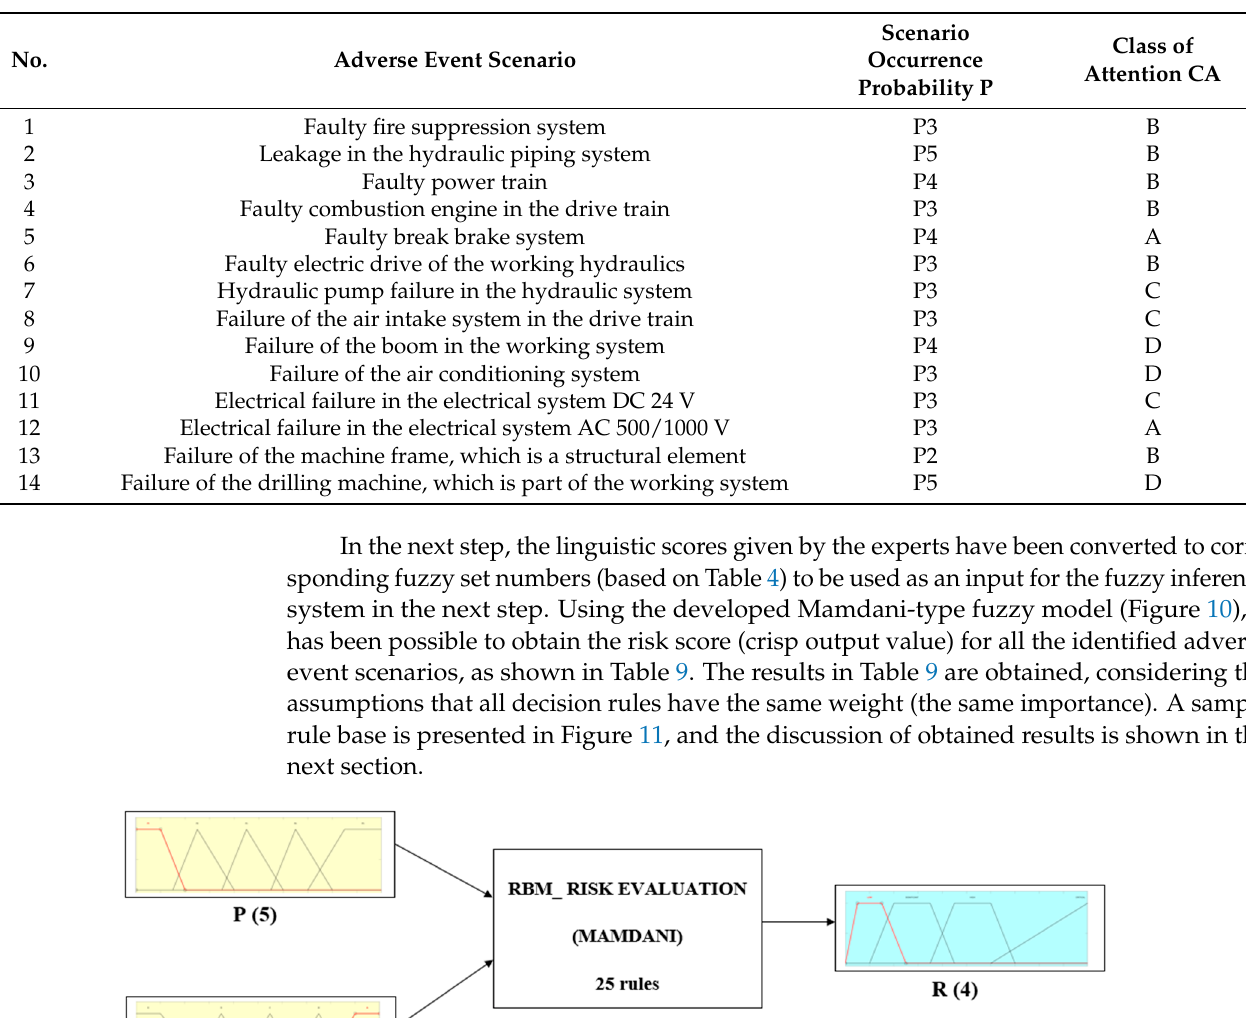
Table 8. Parameters linguistic scores for all identified adverse event scenarios, based on experts’ opinions.